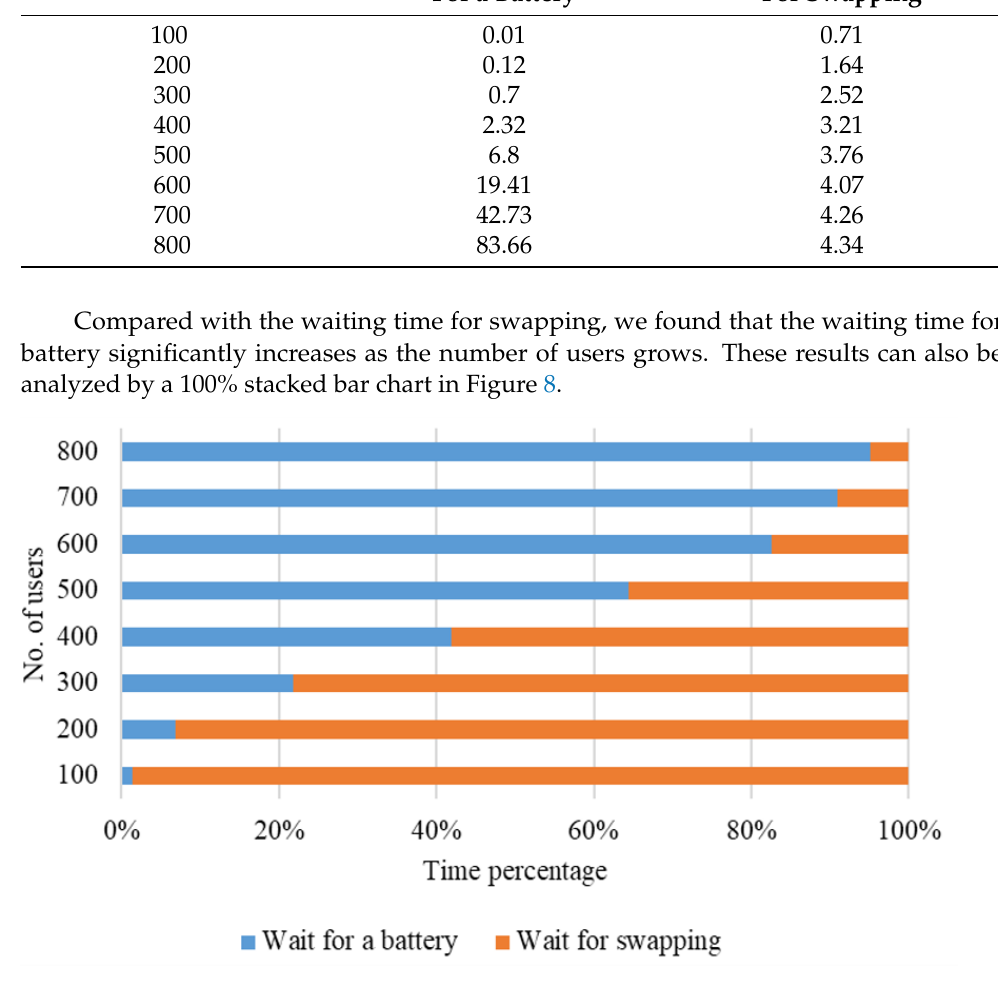
Figure 8. Waiting time